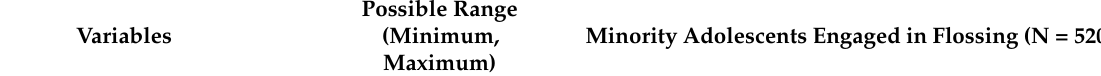
Table 6. Comparing mean scores of the MTM constructs among minority adolescents who floss vs. who do not (N =